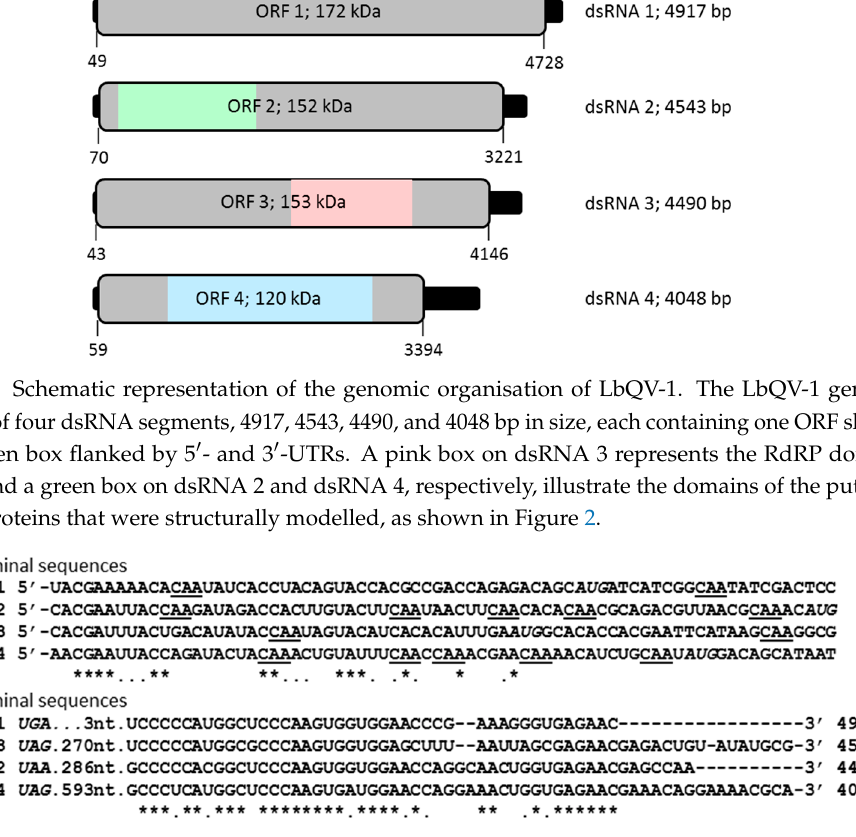
Figure 4. Terminal sequence domains of the LbQV-1 genome. Sequences of the 5 (cid:48) - ( A ) and 3 (cid:48) -termini ( B ). Identical sequences are denoted by asterisks and sequences present in ¾ dsRNAs are shown as dots. CAA repeats in the 5’terminal region are underlined and the possible initiation AUG codons and termination codons UGA, UAA and UAG are shown in italics.